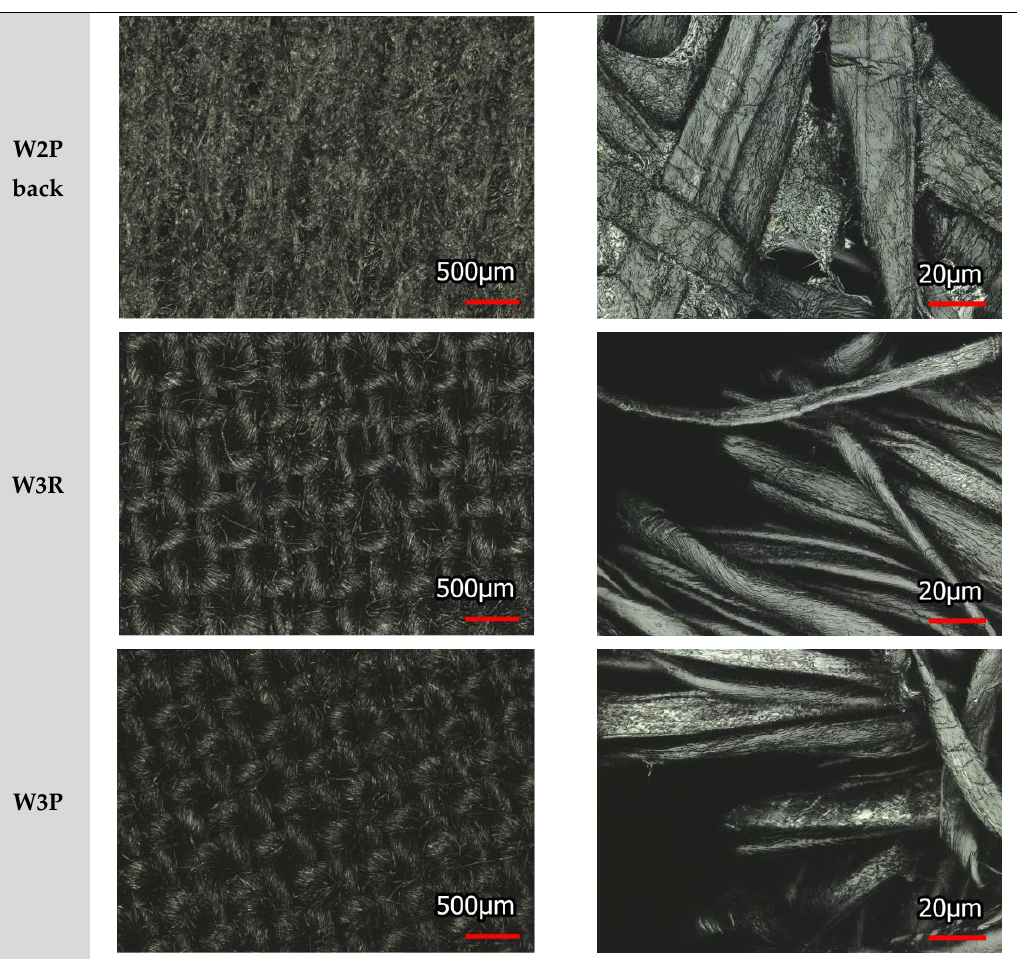
Figure A5. Laser Scanning Microscopic Images of the untreated and plasma-treated wipes in both sides (only for nonwovens) at magnifications of 10× and 100×.